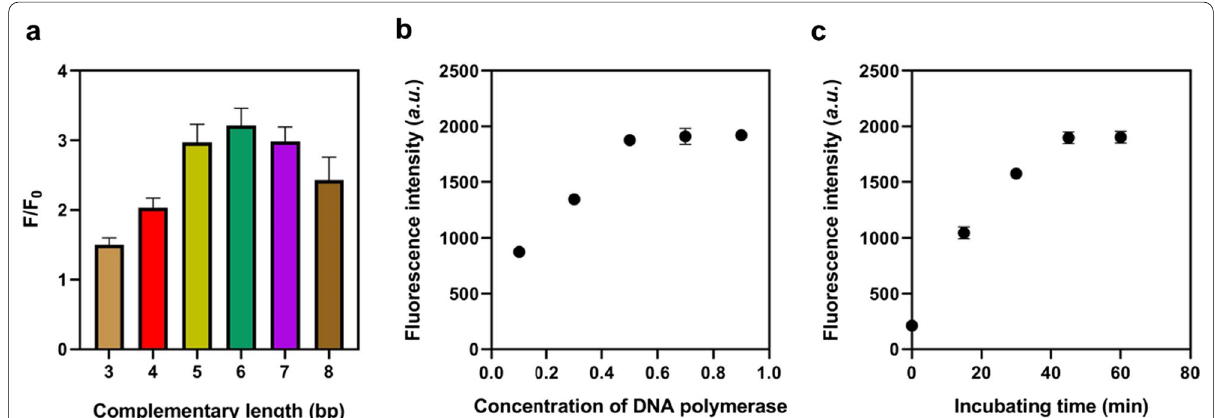
Fig. 3 Optimization of experimental conditions. a F / F 0 result of the allosteric probe with different complementary lengths when ATP existed or not. b Fluorescence intensity of the approach for ATP detection when incubated with different DNA polymerase. c Fluorescence intensity of the approach for ATP detection with different incubation